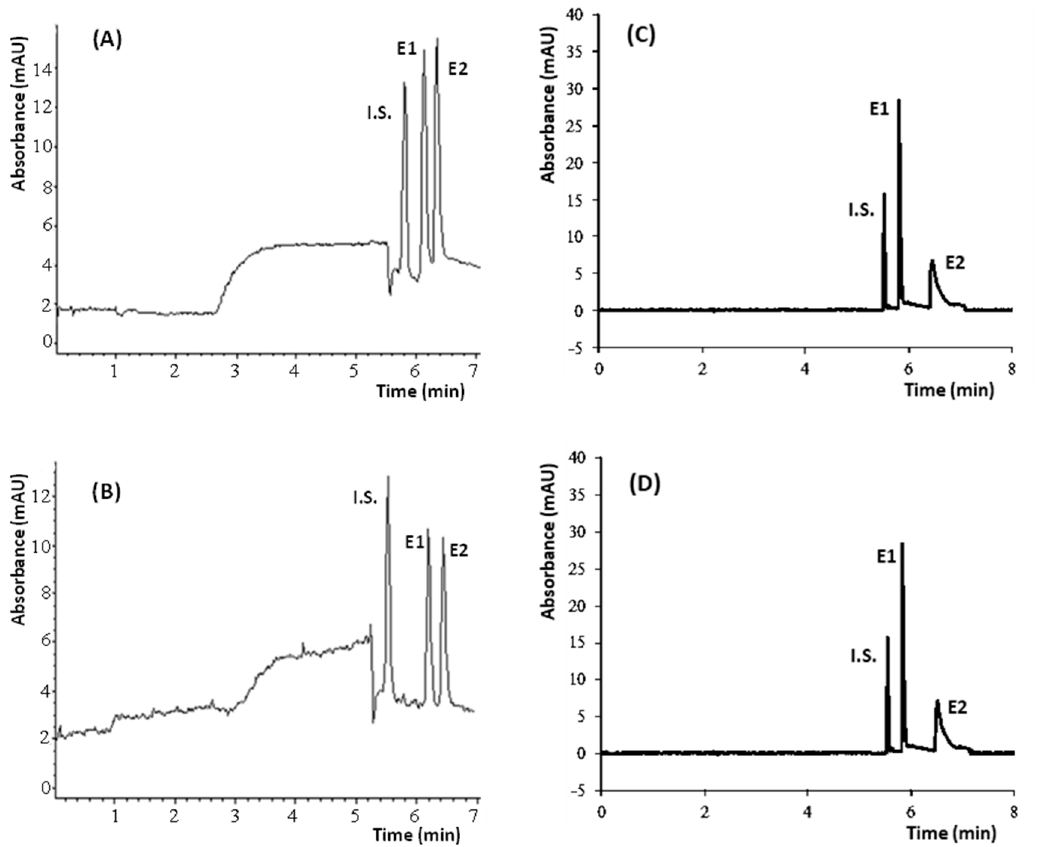
Figure 2. Electropherograms of samples containing racemic mixtures of ( A , B ) verapamil (VER) and ( C , D ) citalopram (CIT) taken at t = 0 ( A , C ), t = 15 ( B ) and t = 28 ( D ) days of incubation. Experimental conditions detailed in Section 2.3. Initial racemate concentrations were 100 and 200 mg L − 1 for VER and CIT, respectively. I.S., internal standard: acetanilide ( A , B ) and ranitidine ( C , D ) for VER and CIT, respectively; E1 and E2, first and second eluted enantiomer, respectively.